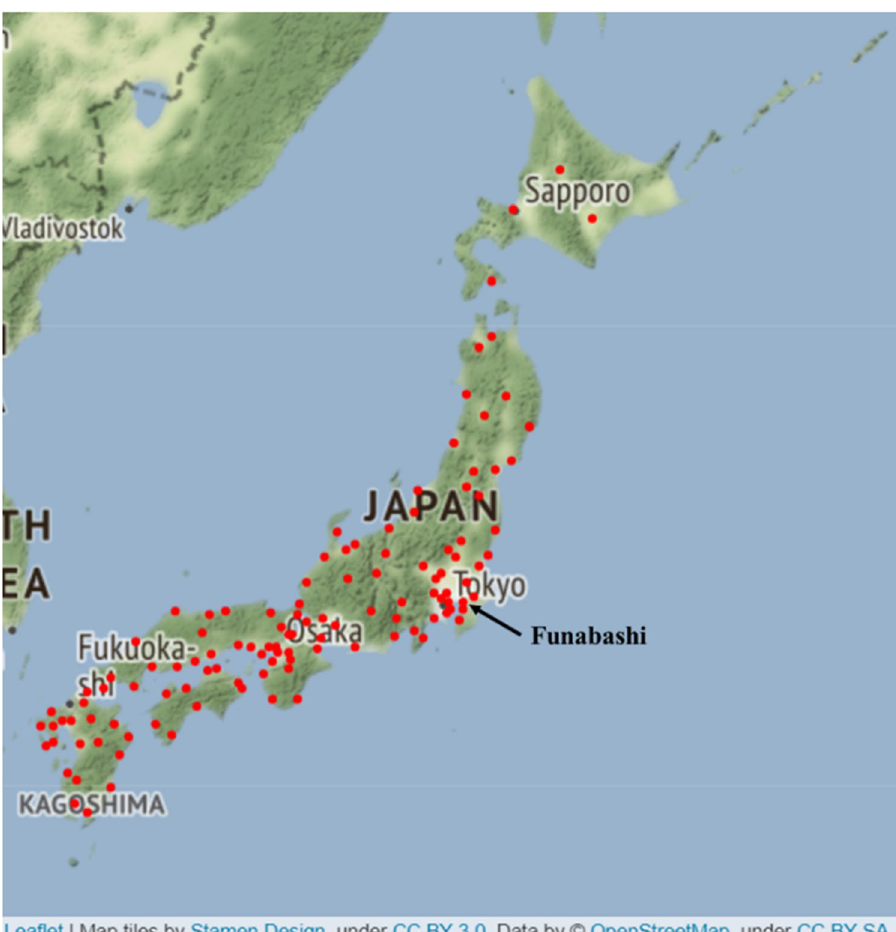
Figure 2. Installation locations of KH-3000-01 samplers in Japan (red dots) and experimental site at Funabashi. Generated by Stamen Maps http:// maps. stamen. com/# water color/ 12/ 37. 7706/- 122. 3782 (Accessed Oct. 22, 2021) and python-visualization, 2020. Folium , https:// python- visua lizat ion. github. io/ folium/ (Accessed Oct. 22, 2021). Installation locations were obtained from Japanese Ministry of the Environment https:// kafun. env. go. jp/ (in Japanese) (Accessed Oct. 22,